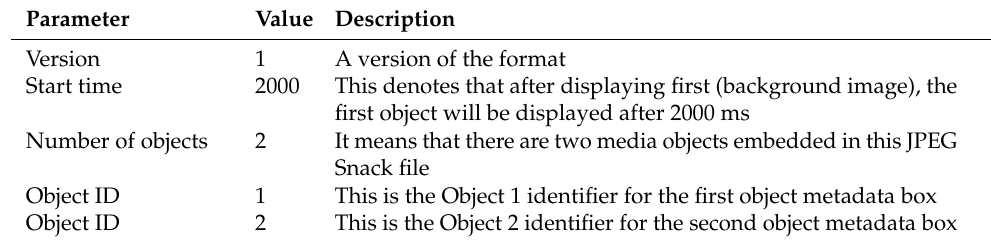
Table A12. Values of the JSDB parameters for the fourth example.